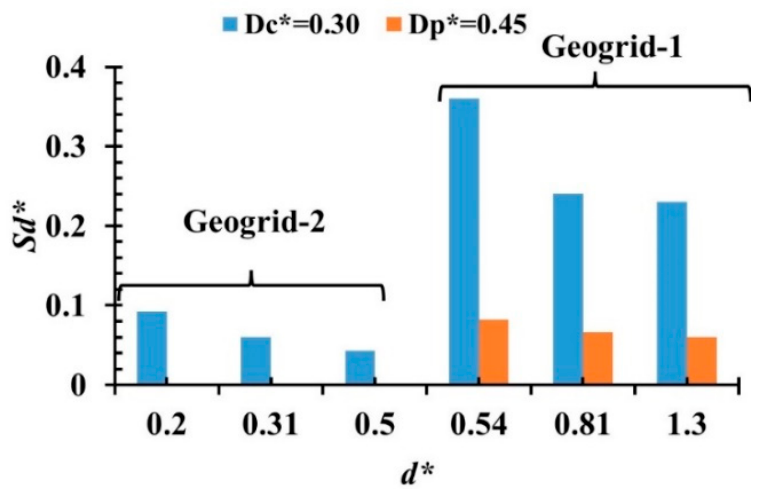
Figure 10. Relation between maximum scour depth ( S d ∗ ) and dimensionless aperture size ( d ∗ ) at 𝑫 𝒄 ∗ = 0.2.